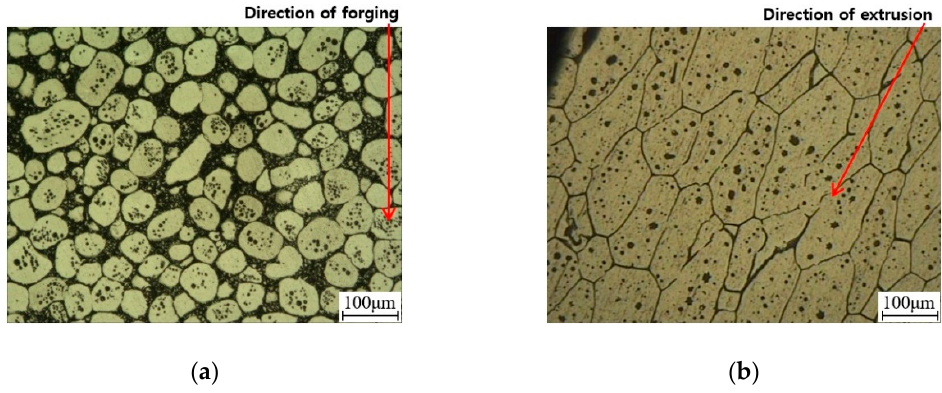
Figure 17. Microstructures of produced final part: ( a ) forged part; ( b ) extruded part.